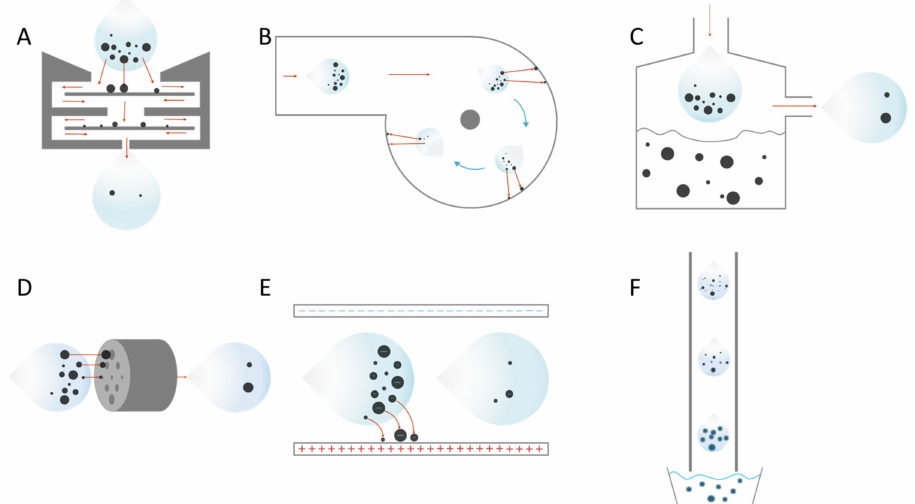
Figure 1. Schematic illustration of primary mechanisms for collection of airborne virus. ( A ) Impactor; ( B ) Cyclone; ( C ) Impinger; ( D ) Filtration; ( E ) Electrostatic precipitator; ( F ) Amplification. Images were modified from [59] with